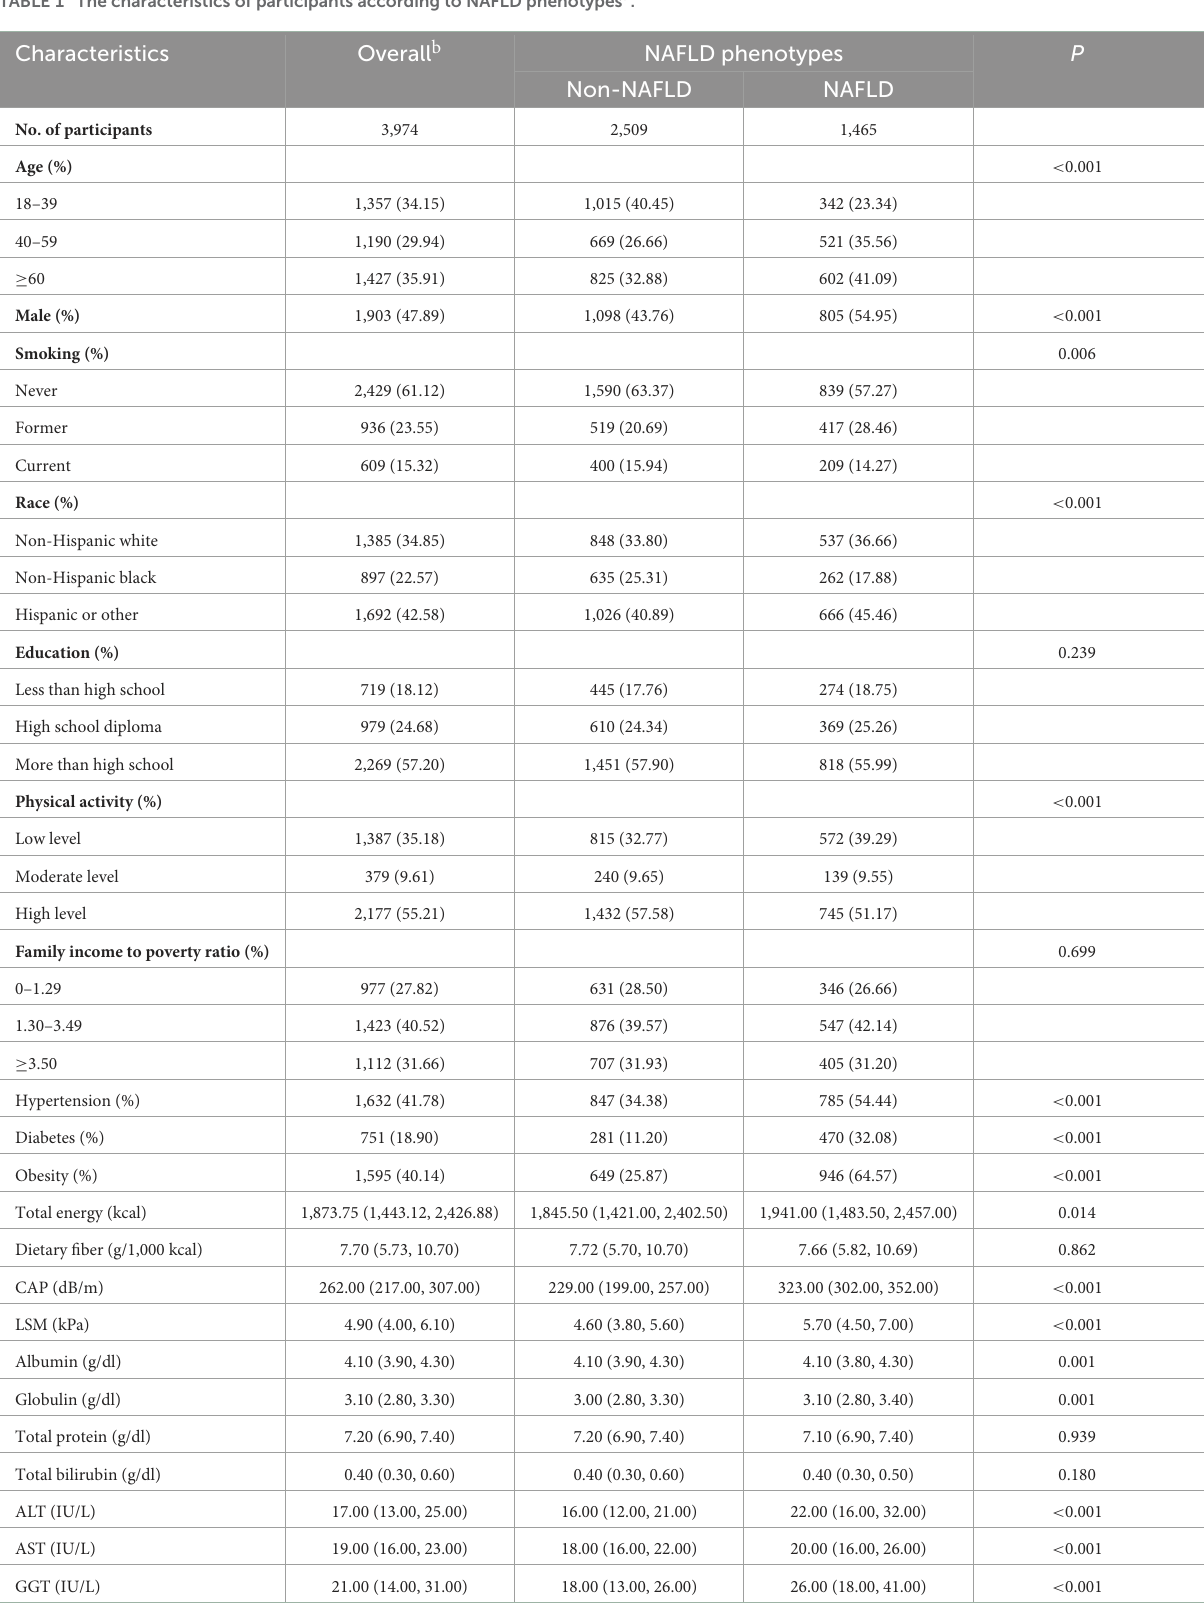
TABLE 1 The characteristics of participants according to NAFLD phenotypes a